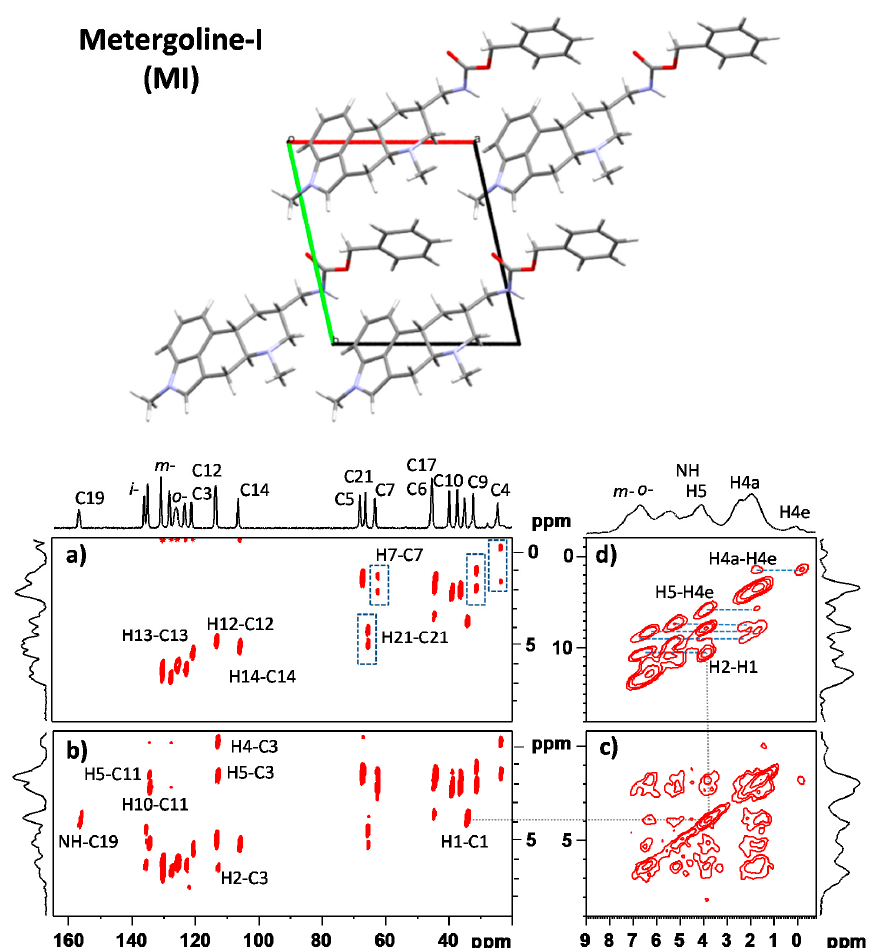
Figure 2. X-ray diffraction (XRD) crystal structure [15] and two-dimensional (2D) 1 H– 13 C FSLG HETCOR NMR spectra of MI measured with 100 and 300 μ s CP mixing times are shown in panels ( a ) and ( b ), respectively; 2D 1 H– 1 H CRAMPS NMR spectrum of MI measured with a 25 μ s spin-diffusion period ( c ); and 2D 1 H– 1 H DQ/SQ CRAMPS NMR spectrum of MI measured with a 40 μ s recoupling period ( d ). Upper projections are provided by one-dimensional (1D) 13 C CP/MAS and 1 H CRAMPS NMR spectra. The connectivity of individual structural units is indicated. For the full-size spectra, see Supporting Information (SI-Experimental details.pdf).